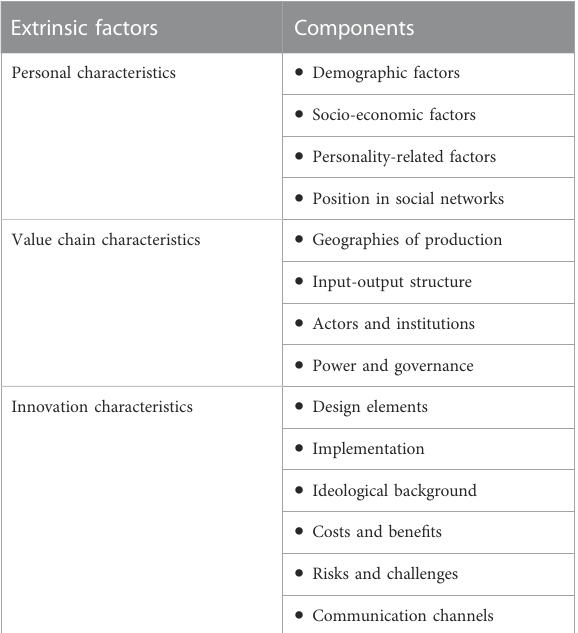
TABLE 1 Overview of the components of extrinsic